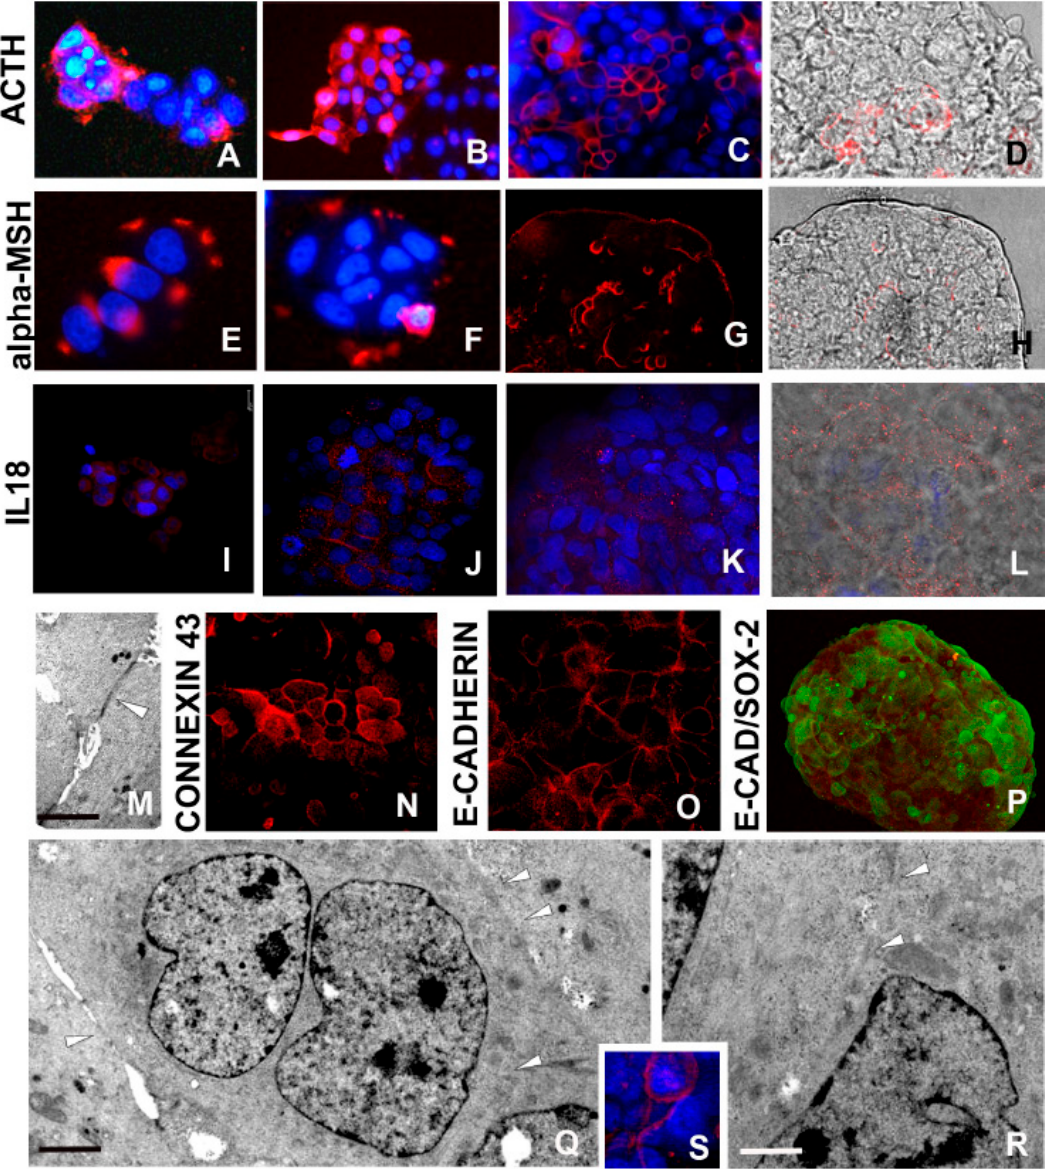
Figure 5. Morpho ‐ functional characterization of cells in developed spheroids: ACTH/ α‐ MSH, interleukin (IL)18 expressions and opening of stable intercellular bridges ( A – H ). Laser confocal microscope analysis. Representative micrographs depicting ACTH and α‐ MSH expression by immunocytochemical characterization. At 24 h ( A , E ) and 3 days ( B , F ) spheroid culture, the signal is quite strong, whereas in mature spheroids ( C , D , G , H ), the signal is superficially localized. In D and H panels, red signal (immunolocalization) and bright field were superimposed to better identify the involved area of spheroid. ( I – L ) IL18 expression is localized in most cells in early aggregates ( I , J ) and especially in peripheral cells of mature spheroid ( K , L ). In L panel, red signal (immunolocalization) and bright field were superimposed. ( M ) TEM analysis. Two neighboring cells are in close contact according to the presence of specialized junctions (arrowhead). Scale bar: ( M ) 2 μ m. ( N – P ) Confocal microscopy images. Starting from 5–7 days, cells are connected by gap junctions that are characterized by Connexin 43 ( N ) and E ‐ cadherin ( O ) expression. Staining with antibody raised against E ‐ cadherin ( O ) shows a punctate pattern at the periphery of the cells. ( P ) Confocal microscopy images. Double labelling of spheroid cells with antibodies raised against E ‐ cadherin (red) and Sox2 (green) showing that stemness (Sox2) does not match with the gap formation that is considered critical event in growth